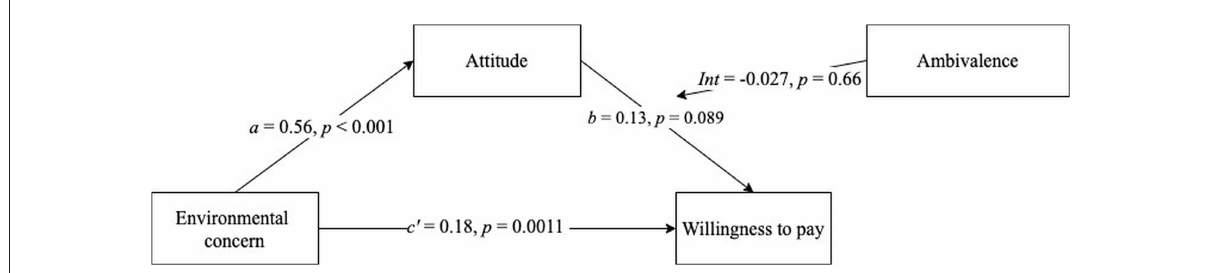
FIGURE3 Moderated mediation analysis visualising the effect of environmental concerns on WTP for suboptimal food mediated by attitudes towards suboptimal food and moderated by ambivalence.